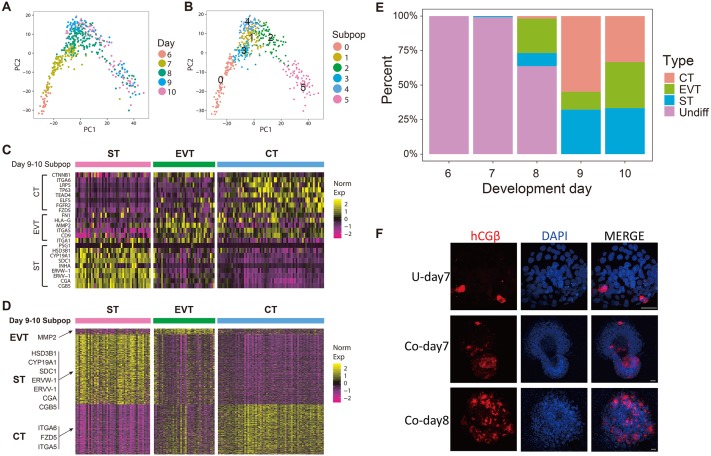
Single-cell RNA-seq revealed the timing of trophoblast differentiation.(A–B) Unbiased clustering based on SNN graph classified trophoblasts into 6 subpopulations. Cells on day 9 and day 10 were classified into 3 subpopulations. (C) Heat map showing the expression of previously defined ST, EVT, or CT marker genes within the 3 subpopulations identified from day 9 and day 10 cells. (D) Heat map showing the expression of genes that were specifically expressed in within the 3 subpopulations identified from day 9 and day 10 cells. We therefore annotated these 3 subpopulations as CT, EVT, and ST, respectively. (E) Stacked bar plot showing the percentage of the CT, EVT, and ST at different development days. The ST first appears at day 7 in cocultured conceptuses, whereas the EVT first appears on day 8. (F) Immunostaining of ST marker gene hCGβ in conceptuses at different stages (scale bars = 100 μm). CT, cytotrophoblast; EVT, extravillous trophoblast; RNA-seq, RNA sequencing; SNN, shared nearest neighbor; ST, syncytiotrophoblast.